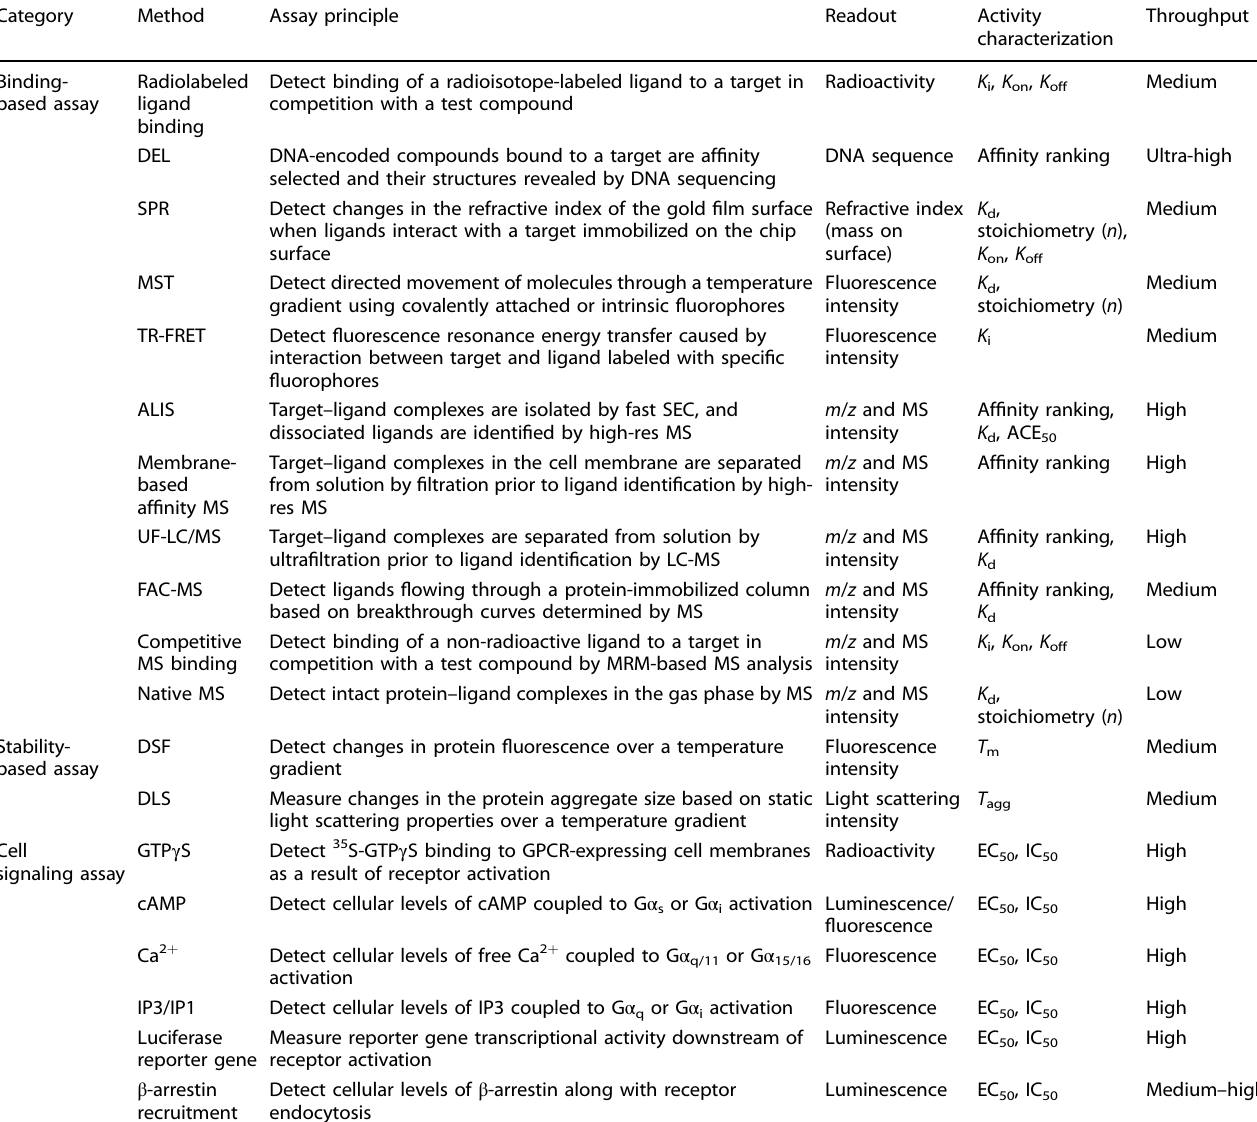
Table 7. Diverse GPCR ligand screening technologies classi fi ed into three categories